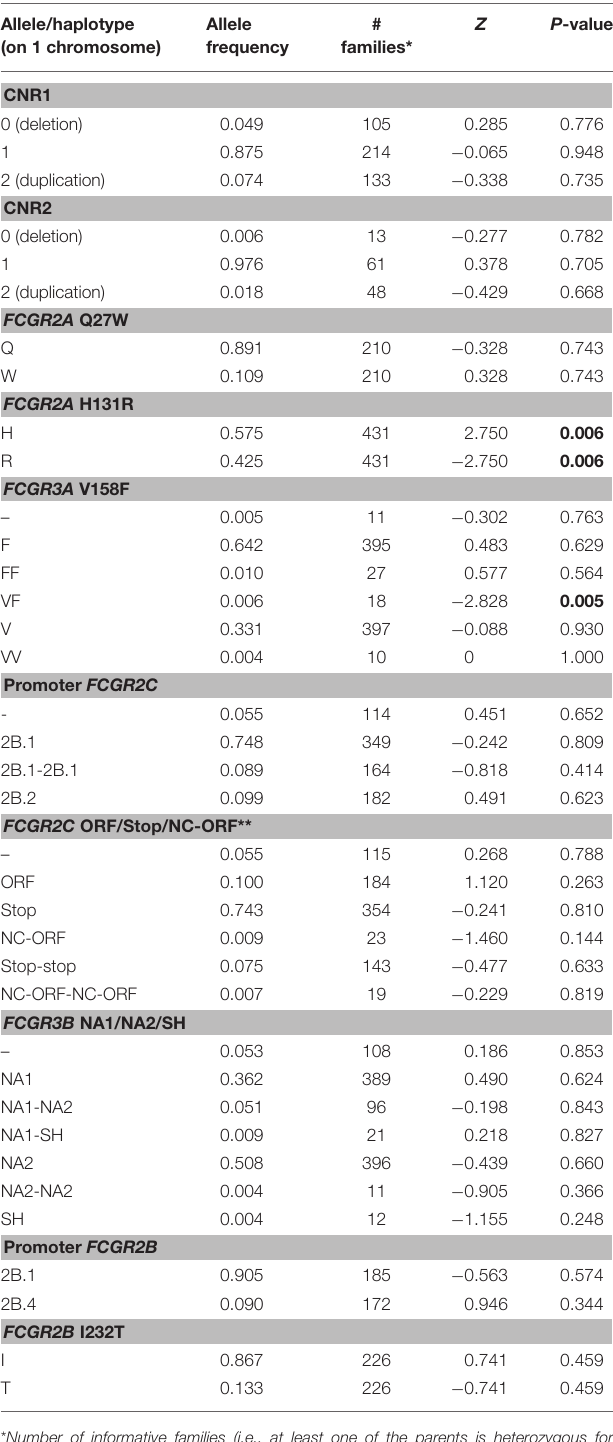
* Number of informative families (i.e., at least one of the parents is heterozygous for the indicated allele or haplotype). Only alleles for which the number of informative families is > 10 are shown. ** ORF means classic FCGR2C-ORF haplotype, NC-ORF means nonclassic FCGR2C-ORF haplotype. Z; Z statistic, a positive Z indicates more transmission than expected, a negative Z indicates less transmission than expected, P indicates whether Z is significantly different from 0, P < 0.05 is considered